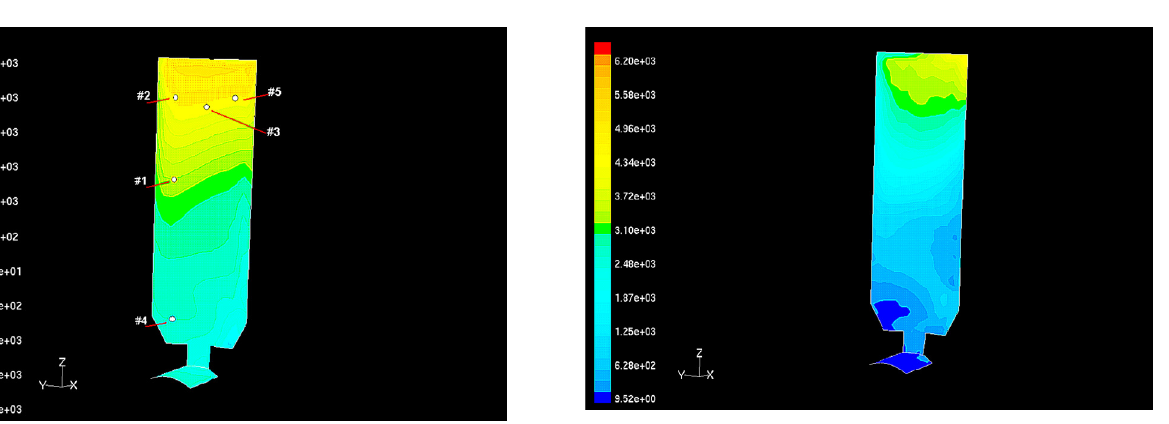
Figure 19: Static pressure distribution on pressure side of a fan blade with radiator (unit in Pascal).